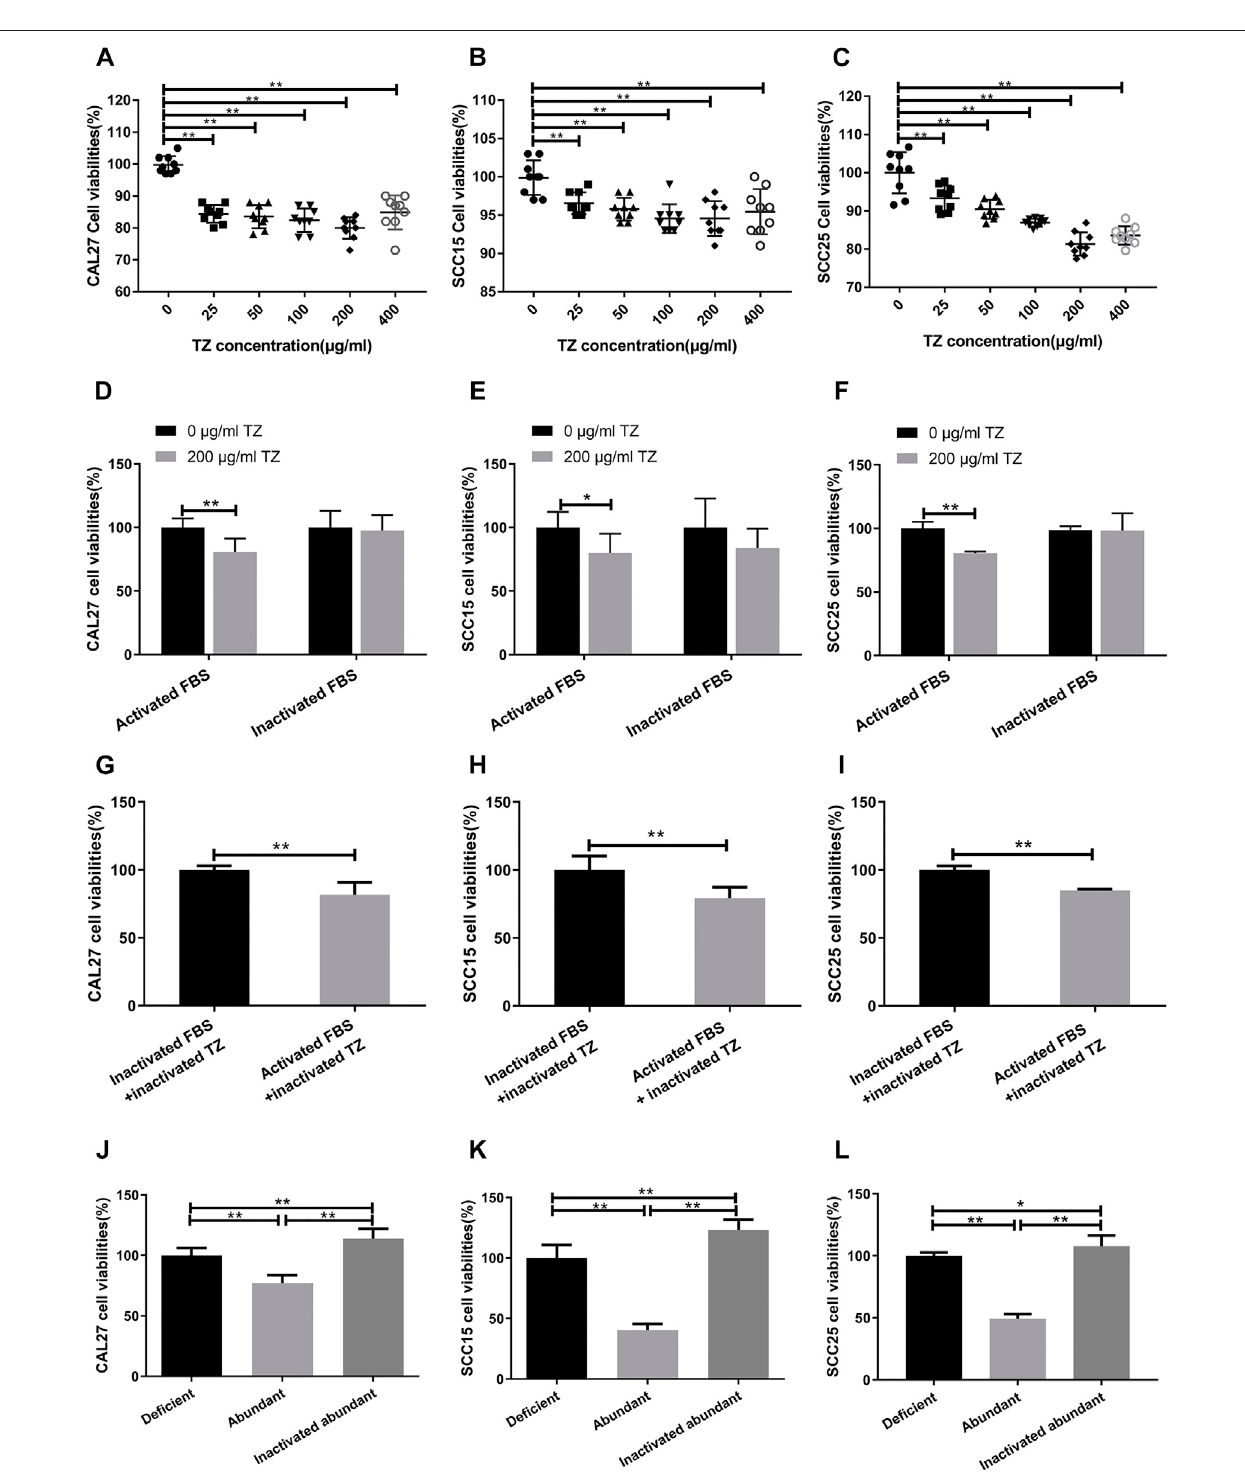
FIGURE 3 | Possible involvement of complement-dependent cytotoxicity. (A – C) Inhibitory effects of trastuzumab (TZ) on proliferation of CAL27, SCC15, and SCC25 cells. A range of the TZ concentrations was used to treat OSCC cells and the concentration of 200 μ g/ml TZ was considered as the optimum concentration for subsequent experiments. (D – F) Viability of CAL27, SCC15, and SCC25 cells treated with 200 μ g/ml TZ in medium containing either 20% inactivated FBS or 20% activated FBS. (G – I) Viability of CAL27, SCC15, and SCC25 cells treated with inactivated 200 μ g/ml TZ in medium containing either 20% inactivated FBS or 20% activated FBS. (J – L) Viability of CAL27, SCC15, and SCC25 cells treated with 20% anti-HER2 IgG-de fi cient plasma, 20% anti-HER2 IgG-abundant plasma and 20% inactivated anti-HER2 IgG-abundant plasma. The data of proliferation were expressed as mean ± SD in cell viability (%). De fi cient, anti-HER2 IgG-de fi cient plasma; Abundant, anti-HER2 IgG-abundant plasma; TZ, trastuzumab; * p < 0.05; ** p < 0.01.